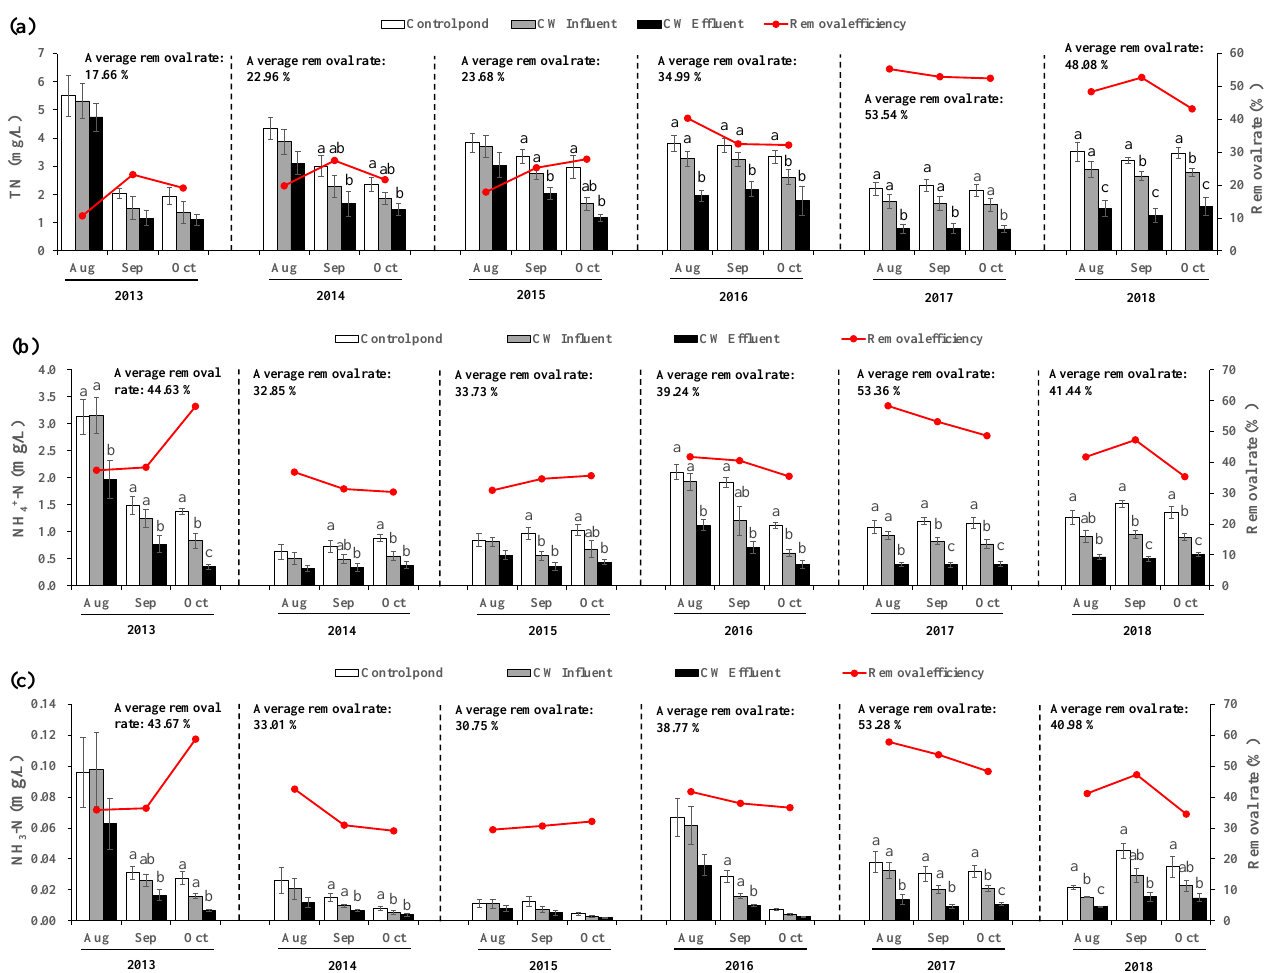
Figure 3. Concentrations of TN ( a ), NH 4+ -N ( b ) and NH 3 -N ( c ) in water samples collected from the control pond and the inlet and outlet of CW, and the removal efficiency during the monitoring period. The value is expressed as mean ± SE ( n = 6), and different small letters in bar graphs indicate significant differences ( p < 0.05) among the control pond, CW influent and CW effluent.